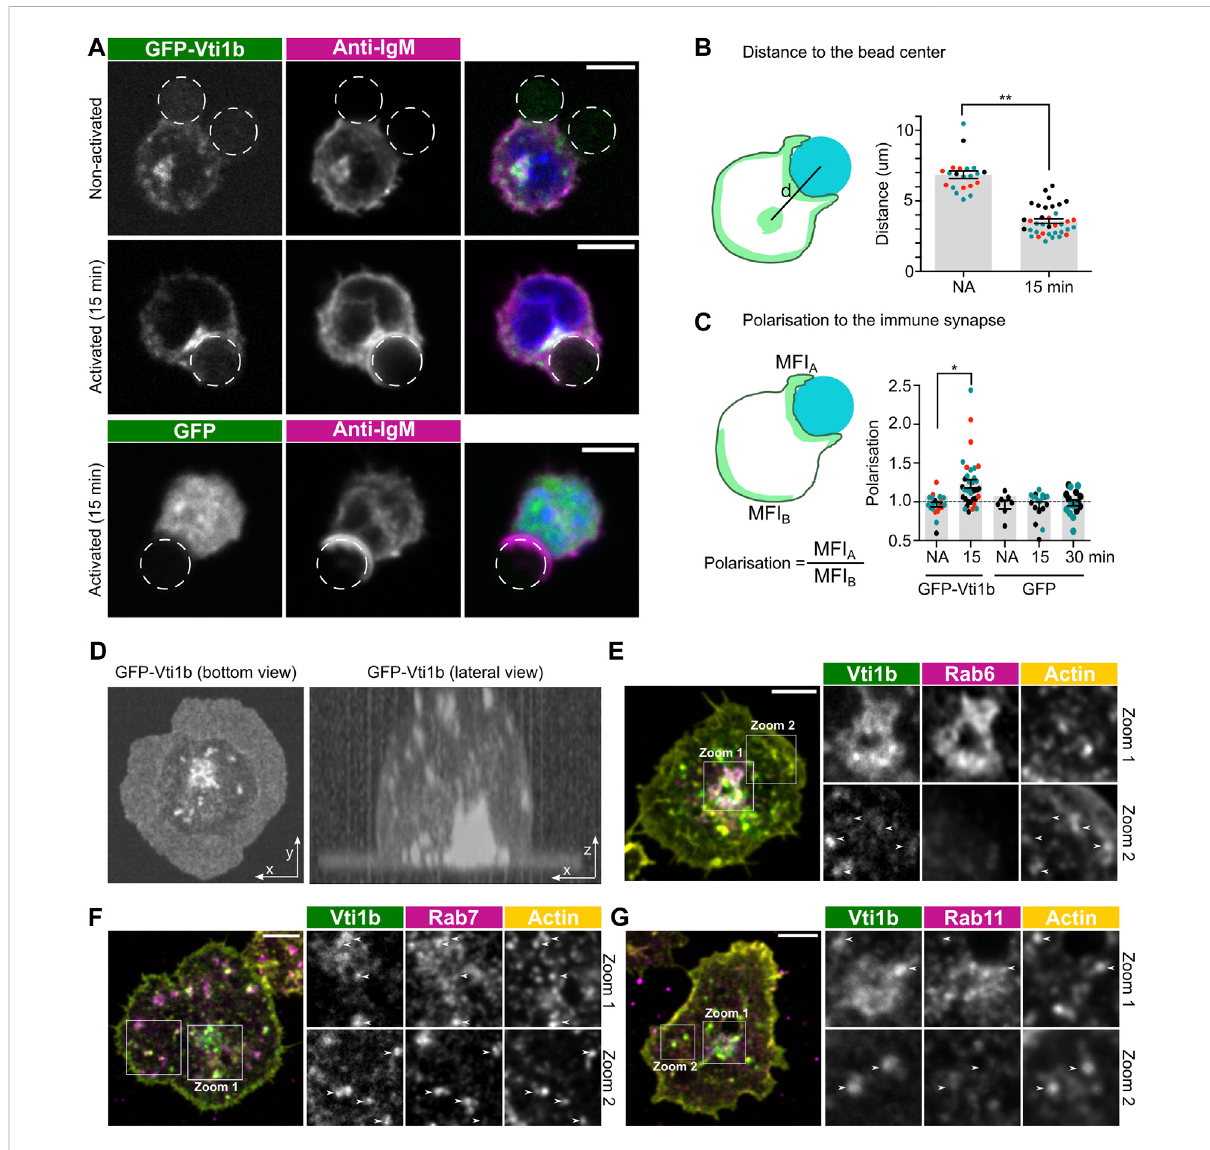
FIGURE 3 Vti1b is polarised to the IS upon activation. (A) A20 D1.3 cells were transfected with GFP-Vti1b or GFP as a control (in green) and activated with anti-IgM coated beads or incubated with uncoated beads (dashed circles) for 15 – 30 min. Cells were stained with anti-BCR antibodies (magenta) to show the accumulation of the BCR at the sites of activation. Scale bar: 5 µm. (B) Quanti fi cation of (A) . The distance from the endosomal compartment (ROI manually selected) to the center of the bead was quanti fi ed as shown in the schematics. NA = non activated. Data are presented as mean ± SEM. Every dot represents one individual cell ( n = 3 independent experiments, shown in black, red, and green). p ** < 0.01. (C) Quanti fi cationof (A) .ThepolarisationofVti1btotheISwasquanti fi edasshownintheschematics.NA=nonactivated.Dataarepresentedasmean± SEM. Every dot represents one individual cell ( n = 2 – 3 independent experiments, shown in black, red, and green). p * < 0.05. (D) A20 D1.3 cells were transfected with GFP-Vti1b and seeded on antigen (activated; anti-IgM) coated glass. Left: bottom view. Right: lateral view. (E – G) A20 D1.3 cells transfected with GFP-Vti1b (green) were seeded on anti-IgM coated glass for 30 min and stained with (E) anti-Rab6 (F) Rab7 or (G) Rab11 (magenta) andphalloidin(actin;yellow).Scalebar:5 µm.ArrowsshowcolocalisationofVti1bwithactinfoci.Individualchannelsforthewholecellcanbefound in Supplementary Figure